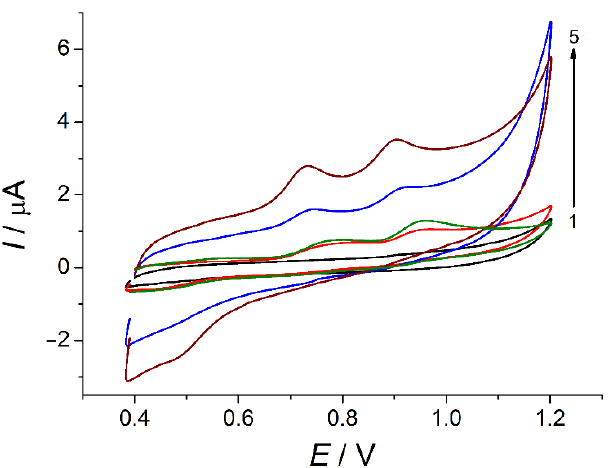
Figure 8. CVs of 10 µM mixture of ferulic acid and vanillin on bare GCE (curve 2), polyBCP/GCE (curve 3), f-SWCNTs/GCE (curve 4) and polyBCP/f-SWCNTs/GCE (curve 5) in BRB, pH 2.0 (curve 1), υ = 100 mV s ‒ 1 .